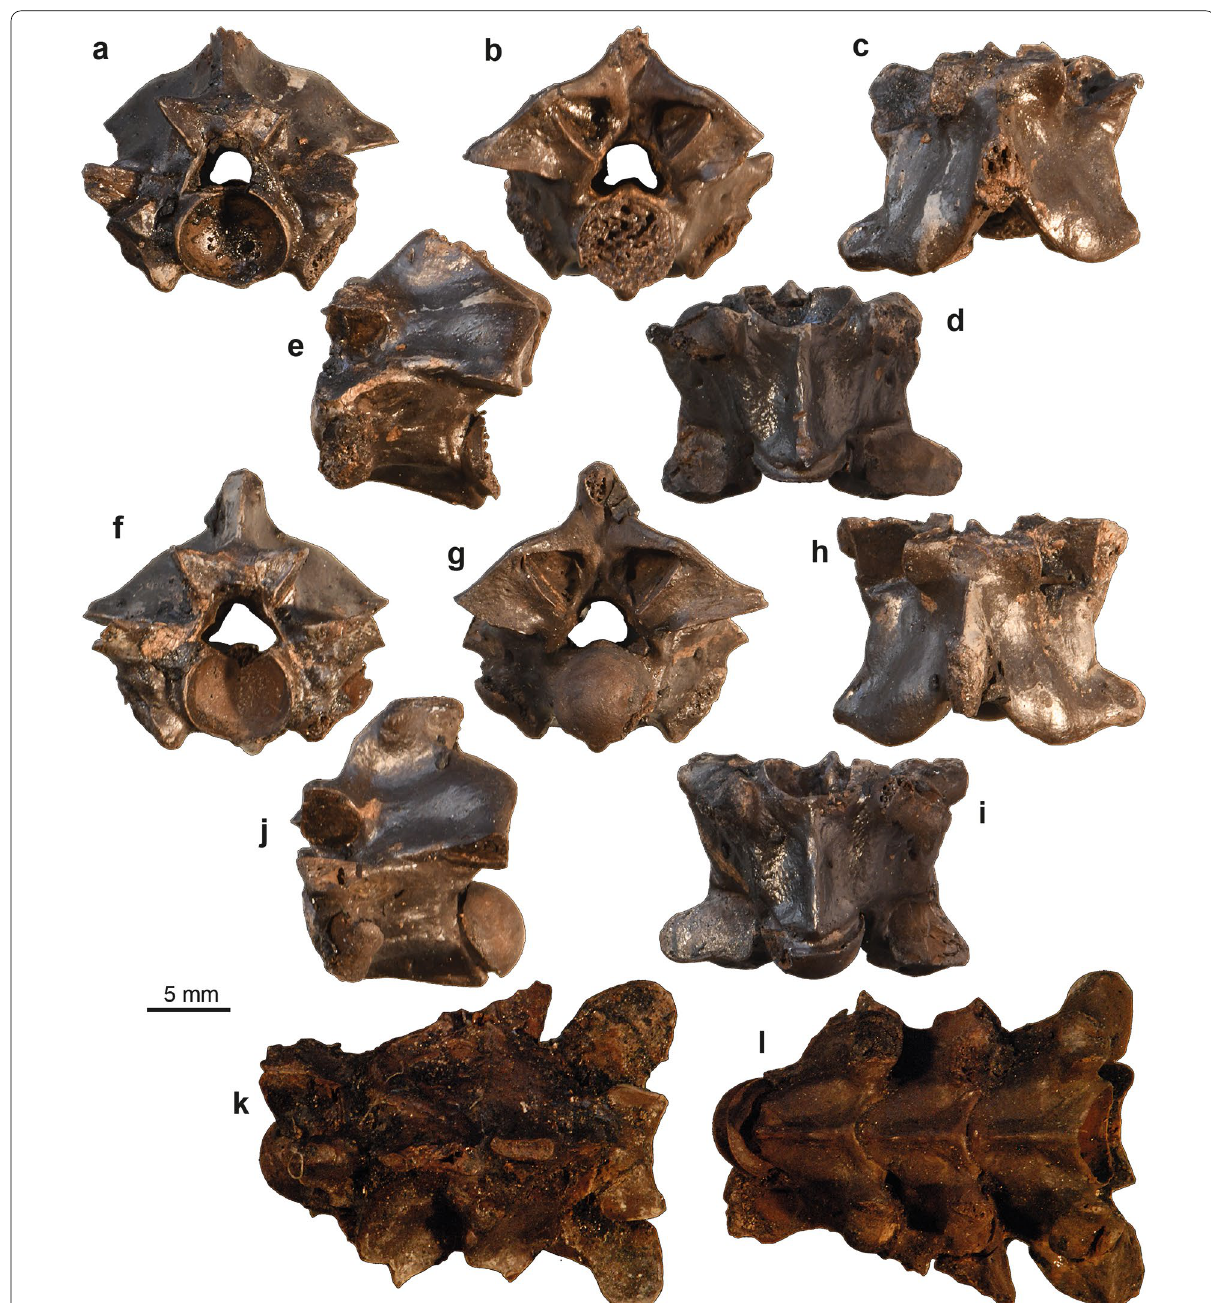
Fig. 59 Eoconstrictor cf. fischeri from quarry XXXV, Geiseltal: a – e mid-trunk vertebra (GMH XXXV-131a-1963) in anterior ( a ), posterior ( b ), dorsal ( c ), ventral ( d ), and left lateral ( e ) views; f – j mid-trunk vertebra (GMH XXXV-131b-1963) in anterior ( f ), posterior ( g ), dorsal ( h ), ventral ( i ), and left lateral ( j ) views; k , l three articulated mid-trunk vertebrae (GMH XXXV-310-1963) in dorsal ( k ) and ventral ( l )